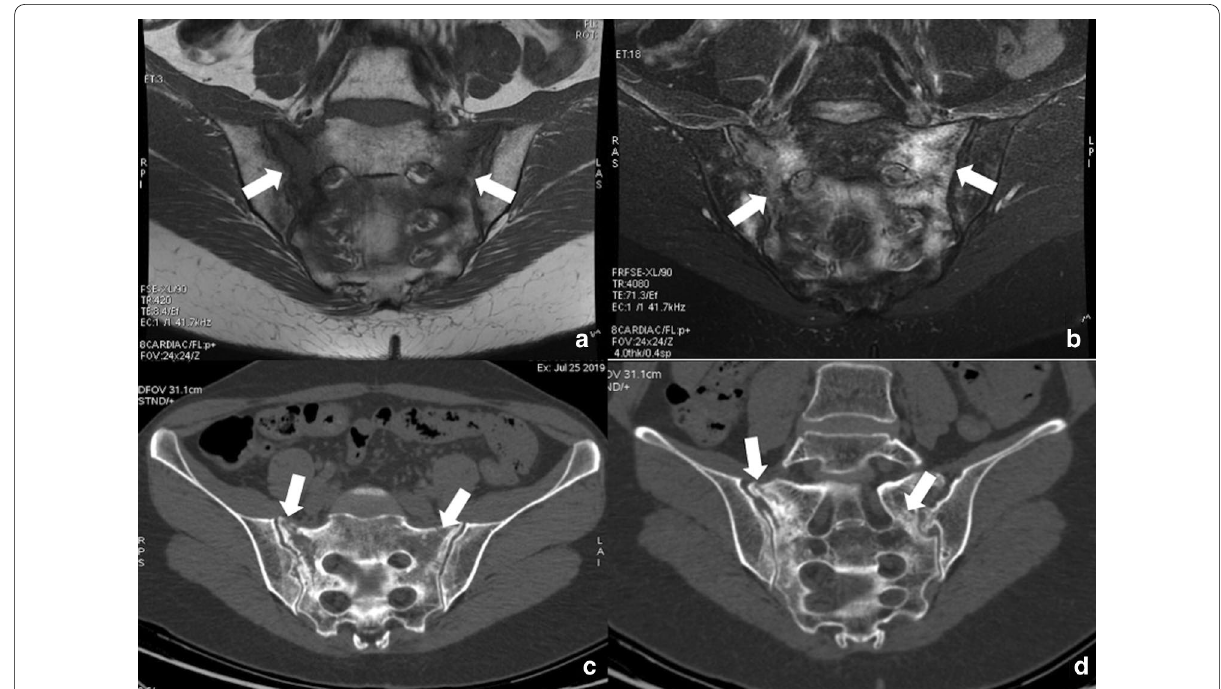
Fig. 26 A 54-year-old woman, who underwent RT/ChT for cervical cancer, complained of low back pain 8 months after treatment completion. MRI exam with coronal oblique T1-weighted and fat suppressed T2-weighted images showed extensive bone marrow edema of the sacrum (arrows in a , b ) due to insufficiency fractures clearly identified also by CT images (arrows in c , d